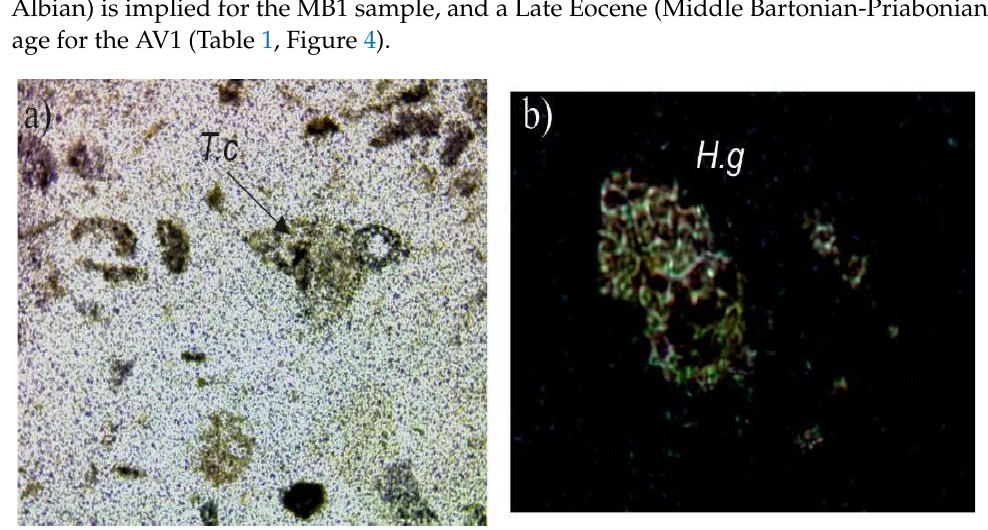
Figure 4. Photomicrographs of characteristic fossils in the studied samples: ( a ) Turborotalia cerroazu- lensis within a Si-rich matrix along with bioclast fragments in Avithos; (axial section × 100); and ( b ) Hedbergella gorbachicae in Myrtos samples (axial section ×